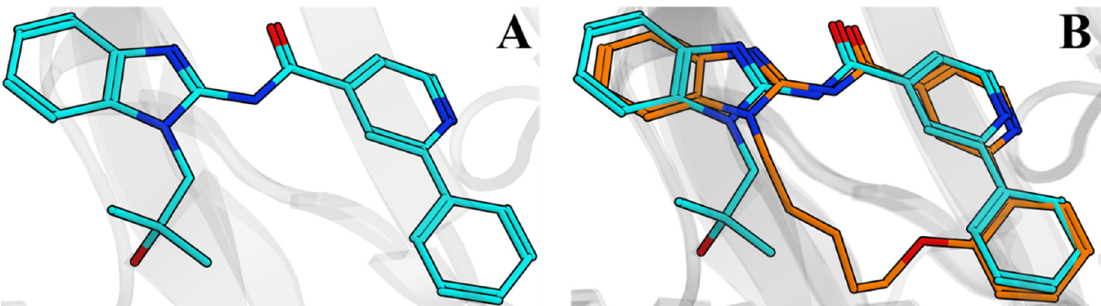
Figure 7. ( A ) X-ray structure of 4b (PDB: 6S9C) in complex with EGFR L858R T790M . ( B ) Overlay of X-ray-based structure of compound 4b (cyan) and X-ray structure of compound 4c (orange, PDB: 6S9D) in complex with EGFR L85R T790M .